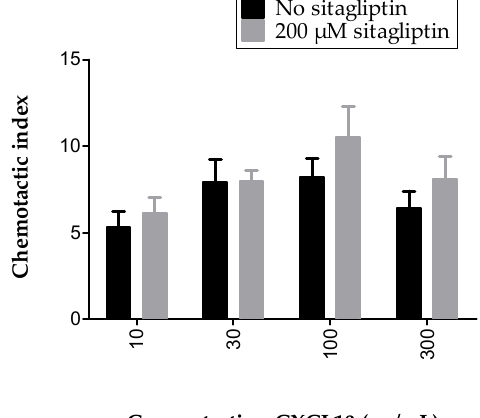
Figure 7. Sitagliptin did not affect CXCL10-induced T cell chemotaxis in vitro. The effects of treatment with 200 µM sitagliptin on the in vitro migratory response of PHA-activated T cells towards 10–300 ng/mL CXCL10 was investigated using the 48 well Boyden chamber chemotaxis assay.